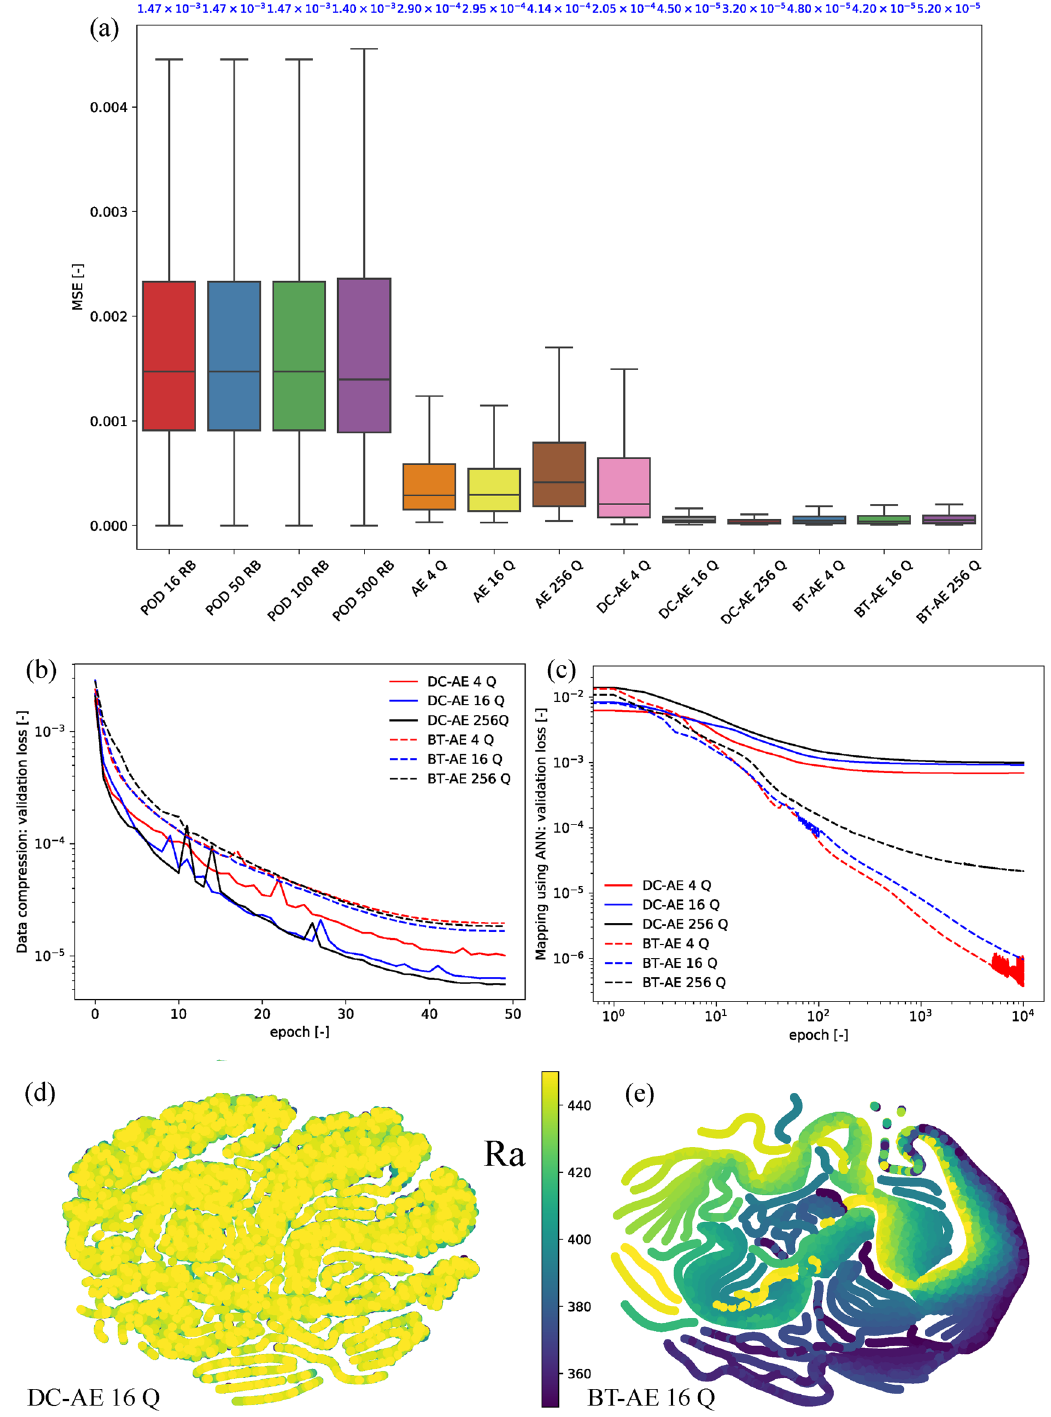
Figure 3. Example 2—results: ( a ) mean squared error (MSE) of each model (please refer to Table 2), and blue texts represent a mean value of the box plots—here we show that BT–AE models provide performance similar to DC–AE models, but POD-based approaches and AE models do not, ( b ) data compression loss for validation set (Eq. 18), ( c ) mapping using ANN loss for validation set (Eq. 19), ( d ) latent space plot of DC–AE 16 Q model, and ( e ) latent space plot of BT–AE 16 Q model. Latent space plots are constructed using t-Distributed Stochastic Neighbor Embedding (t-SNE). Different colors represent each value of Ra value. We calculate the t-SNE plots using Scikit-Learn package using its default setting and perplexity of